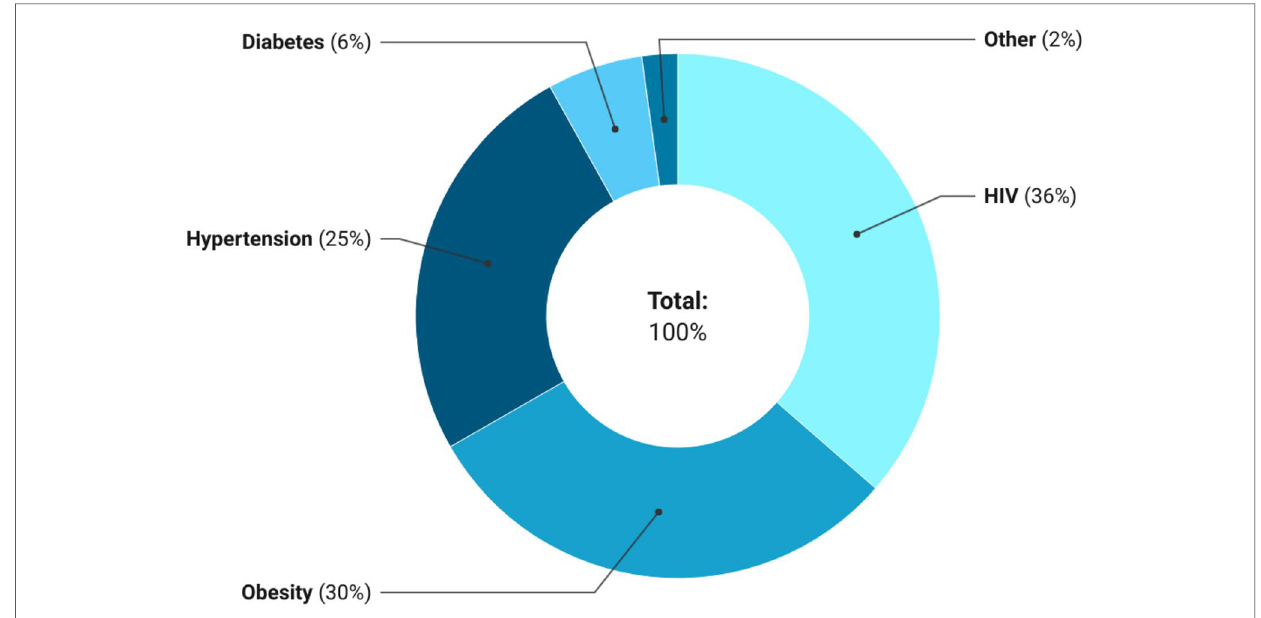
FIGURE 1 Distribution of existing single diseases among those with at least one morbidity in the MHFUS ( n =1,055).